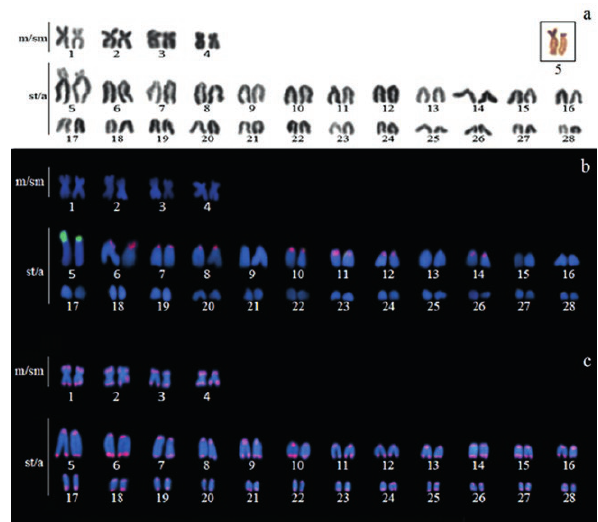
Figure 1. Karyotype for Rineloricaria pentamaculata of the Itiz stream after: a) conventional staining by Giemsa and Ag-NOR located on par Nº 5 (in box); b) double-FISH using 18S rDNA (green) and 5S rDNA (red) probes; c) FISH with telomeric probe. Note the absence of the ITS.